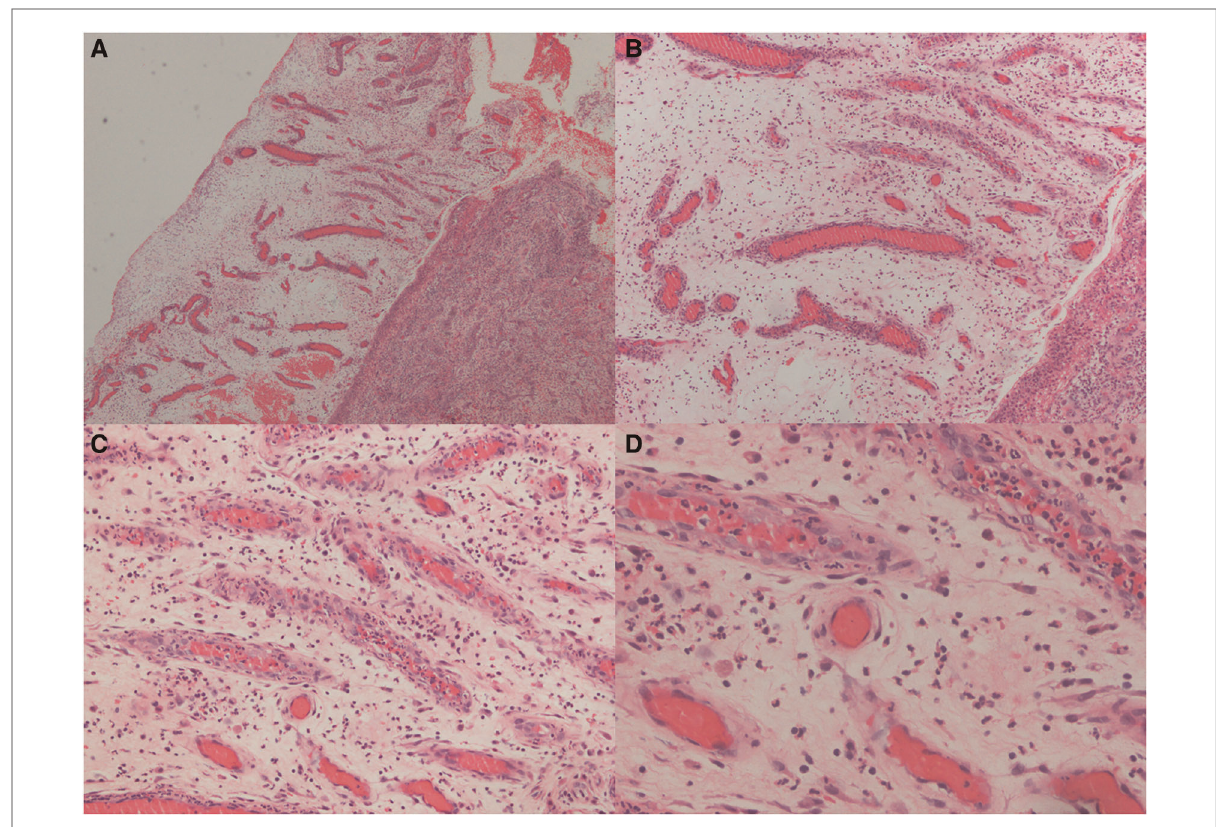
FIGURE 3 Hematoxylin and eosin (HE) staining of the induced membrane tissue at different magni fi cations. The developed membranes were widely dispersed and had considerable neovascularization, which increased the likelihood that the fl ap transplant would survive (magni fi cation from A – D are: 40x, 100x, 200x,